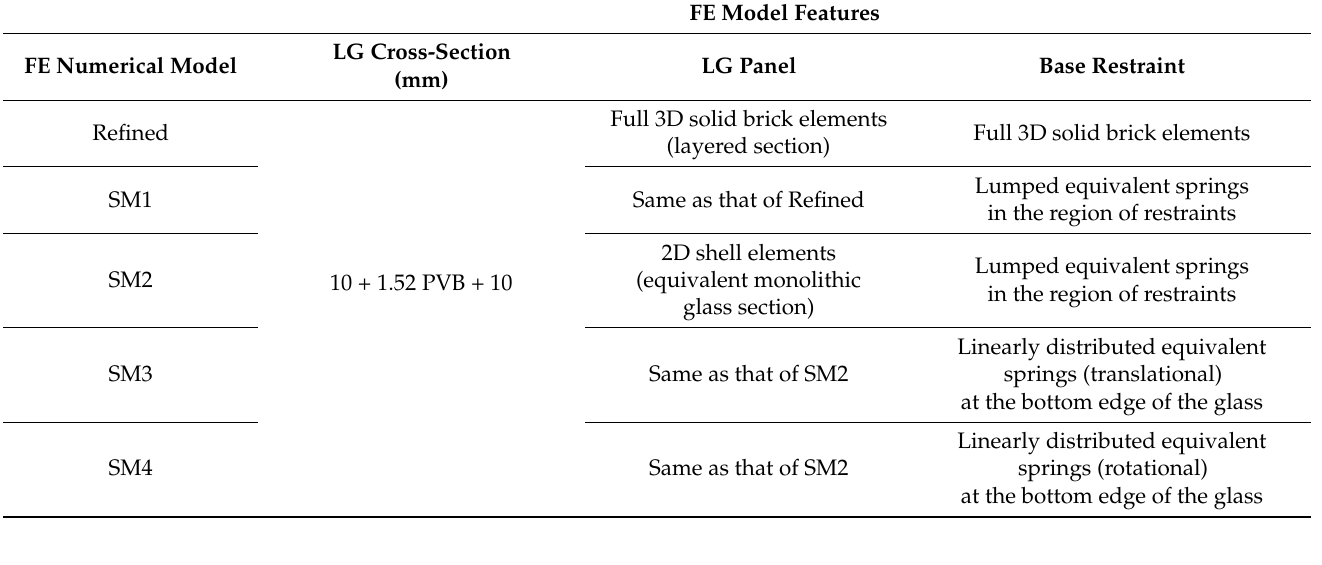
Table 1. Summary of presently developed numerical models for the analysis of the glass balustrade system described in Figure 4.